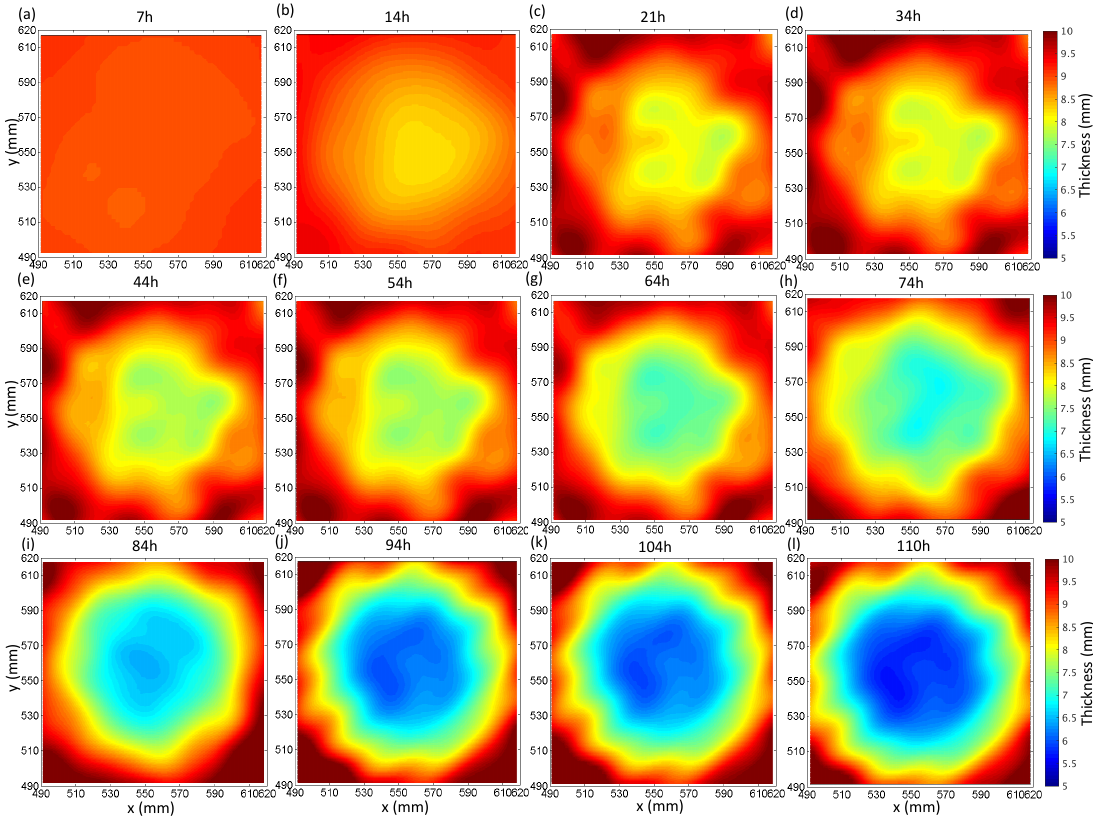
Figure 7. Thickness mapping of the continuous corrosion defect by FWI at 60 kHz. ( a – l ) reconstructed thickness in different corrosion periods corresponding to Figure